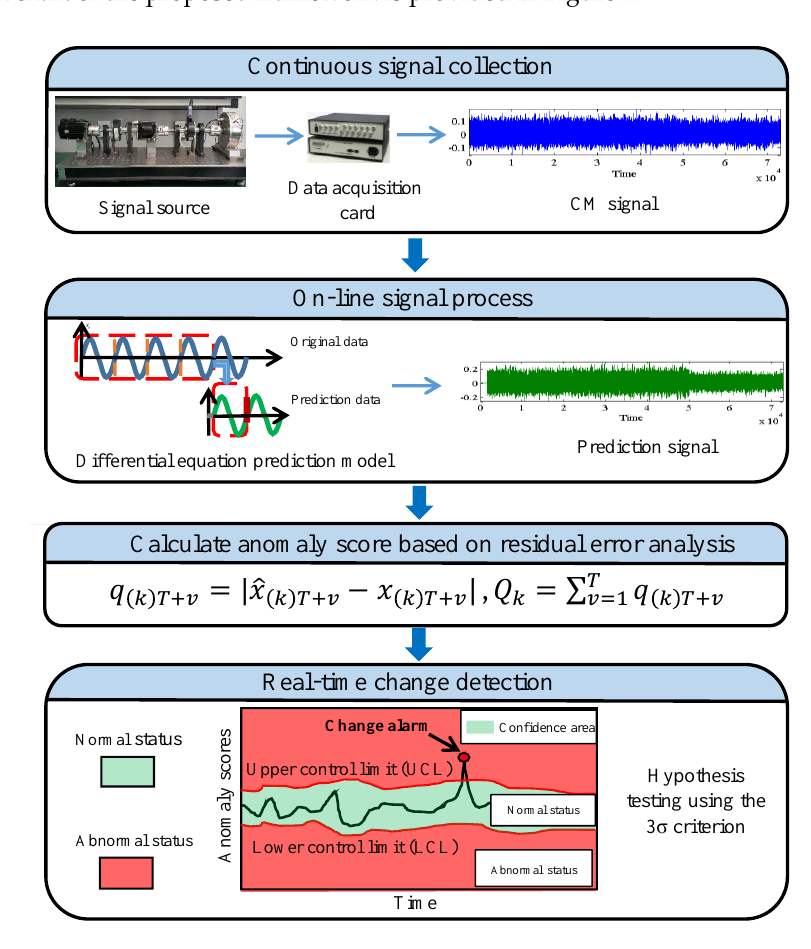
Figure 2. Flowchart of the proposed